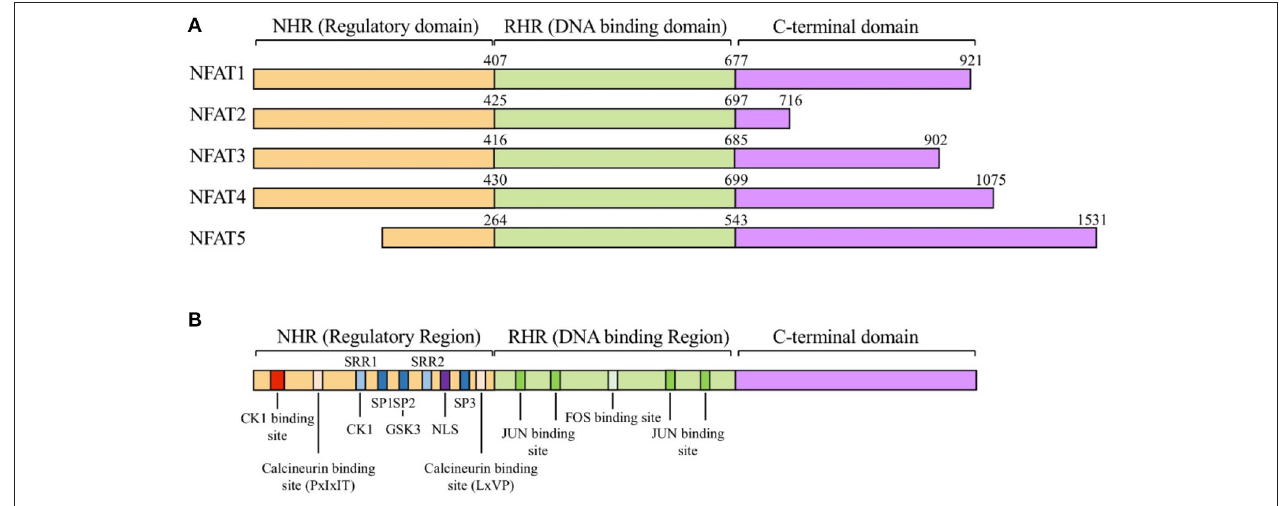
FIGURE 1 | The NFAT protein family and structure of NFATs. (A) General structure of nuclear factor of activated T-cells (NFAT) protein family. The NFAT family consists of five protein members: NFAT1 (NFATc2 or NFATp), NFAT2 (NFATc1 or NFATc), NFAT3 (NFATc4), NFAT4 (NFATc3 or NFATx), and NFAT5 (TonEBP or OREBP). NFAT proteins contain a REL homology region (RHR), NFAT homology region (NHR), and C-terminal domain. RHR, which binds to DNA, is the most conserved domain, and NHR, the regulatory domain, is conserved from NFAT1 to NFAT4, but not in NFAT5. (B) Schematic alignment of NFAT proteins. NHR consists of several conserved regulatory motifs. The NHR contains casein kinase 1(CK1), GSK3 docking site, calcineurin docking site, and PxIxIT and LxVP motifs. NFAT5 lacks the NHR regulatory domain. NHR also contains a nuclear localization signal (NLS), which is required for nucleus translocation, serine-rich regions (SRRs), serine- proline-repeat